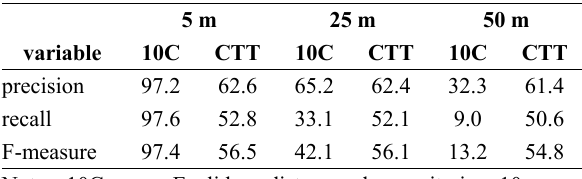
Table 4. Results for the essay P4 (random